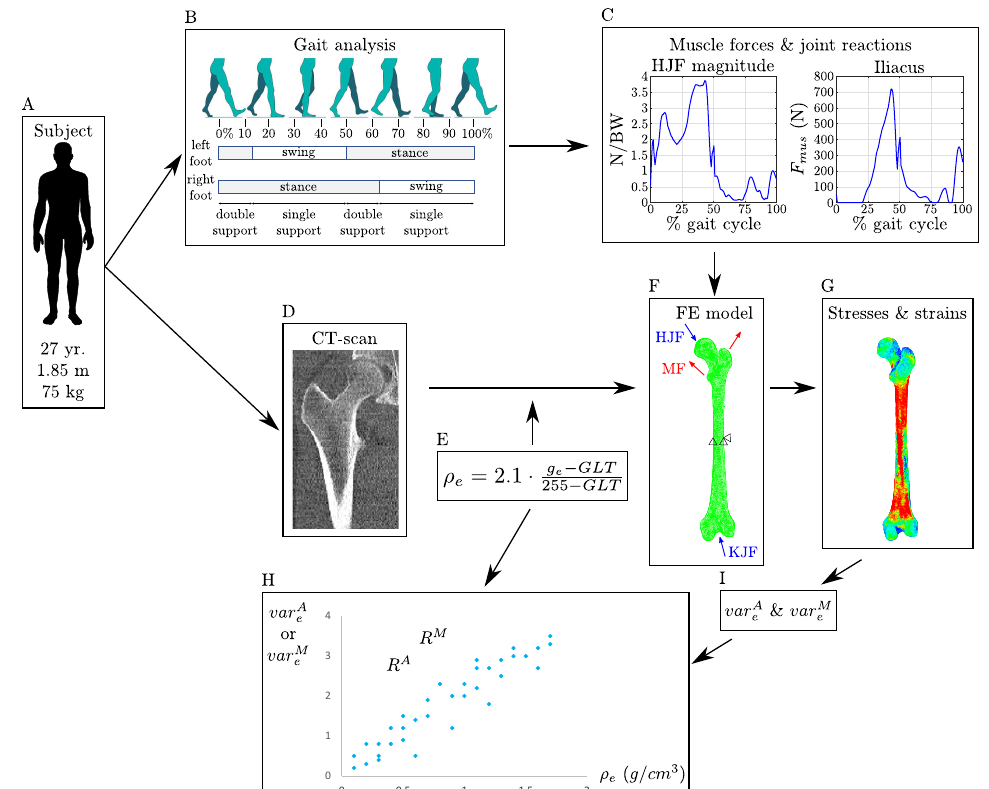
Figure 1. The summary of the procedure followed in this work. One male subject was selected for the study ( A ). A CT scan ( D ) was used to build a FE model of the subject’s femur ( F ). The gait analysis ( B ) perfomed on the same subject was used ( C ) to estimate the muscle forces (MF) and joint reaction forces (HJF: hip joint force, KJF: knee joint force) applied to the FE model, together with isostatic boundary conditions. The mechanical properties of the bone were estimated from the density, which was estimated, in turn, from the CT scan ( E ). The FE simulation of the gait cycle yielded the temporal evolution of stresses and strains ( G ) throughout the cycle. A set of variables ( I ) were derived from those temporal evolutions. Finally, these variables were correlated ( H ) to the bone apparent density in order to evaluate a good predictor of density for bone remodelling